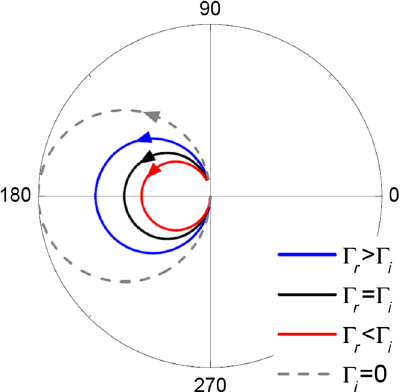
FIG. 12. CMT analysis of a two-port, single-mode resonator. Smith curves for r according to Eq. (C1). Four representative ¼ 0 . 05 f Γ ¼ 0 . 1 f cases are plotted: Γ 0 and 0 (blue curve), i r Γ ¼ 0 . 1 f Γ ¼ 0 . 1 f Γ ¼ 0 . 15 f 0 and 0 (black curve), 0 and i r i Γ ¼ 0 . 15 f Γ ¼ 0 . 1 f Γ ¼ 0 and Γ ¼ 0 . 1 f 0 , 0 (red curve), 0 i r i r (gray curve).